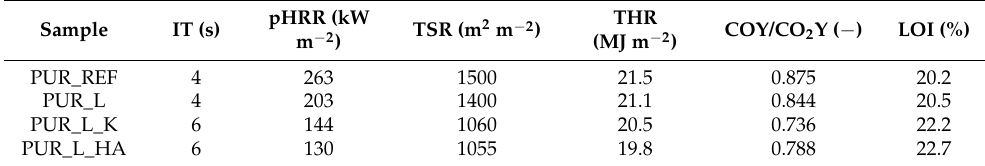
Table 4. Flame retardant properties of PUR composites [13].